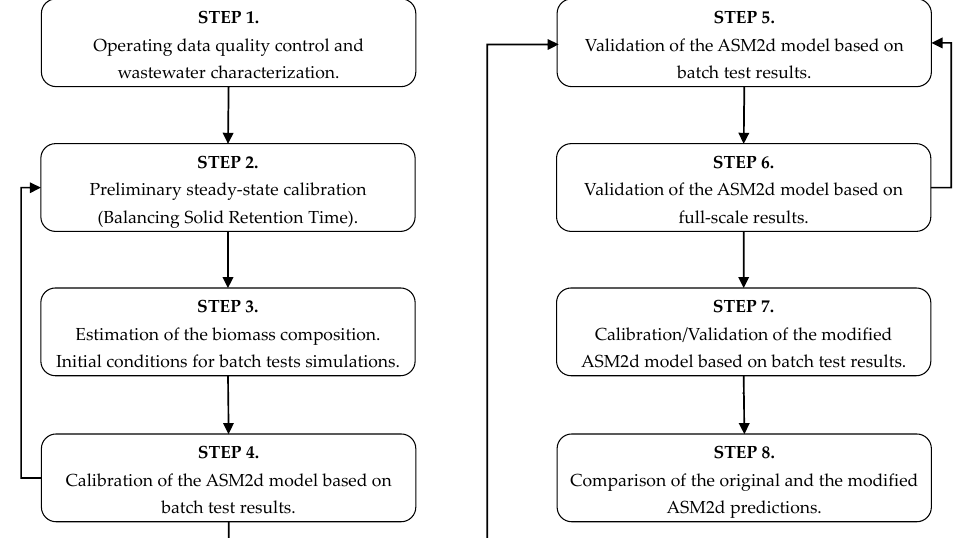
Figure 1. Scheme of the procedure followed in the modelization.